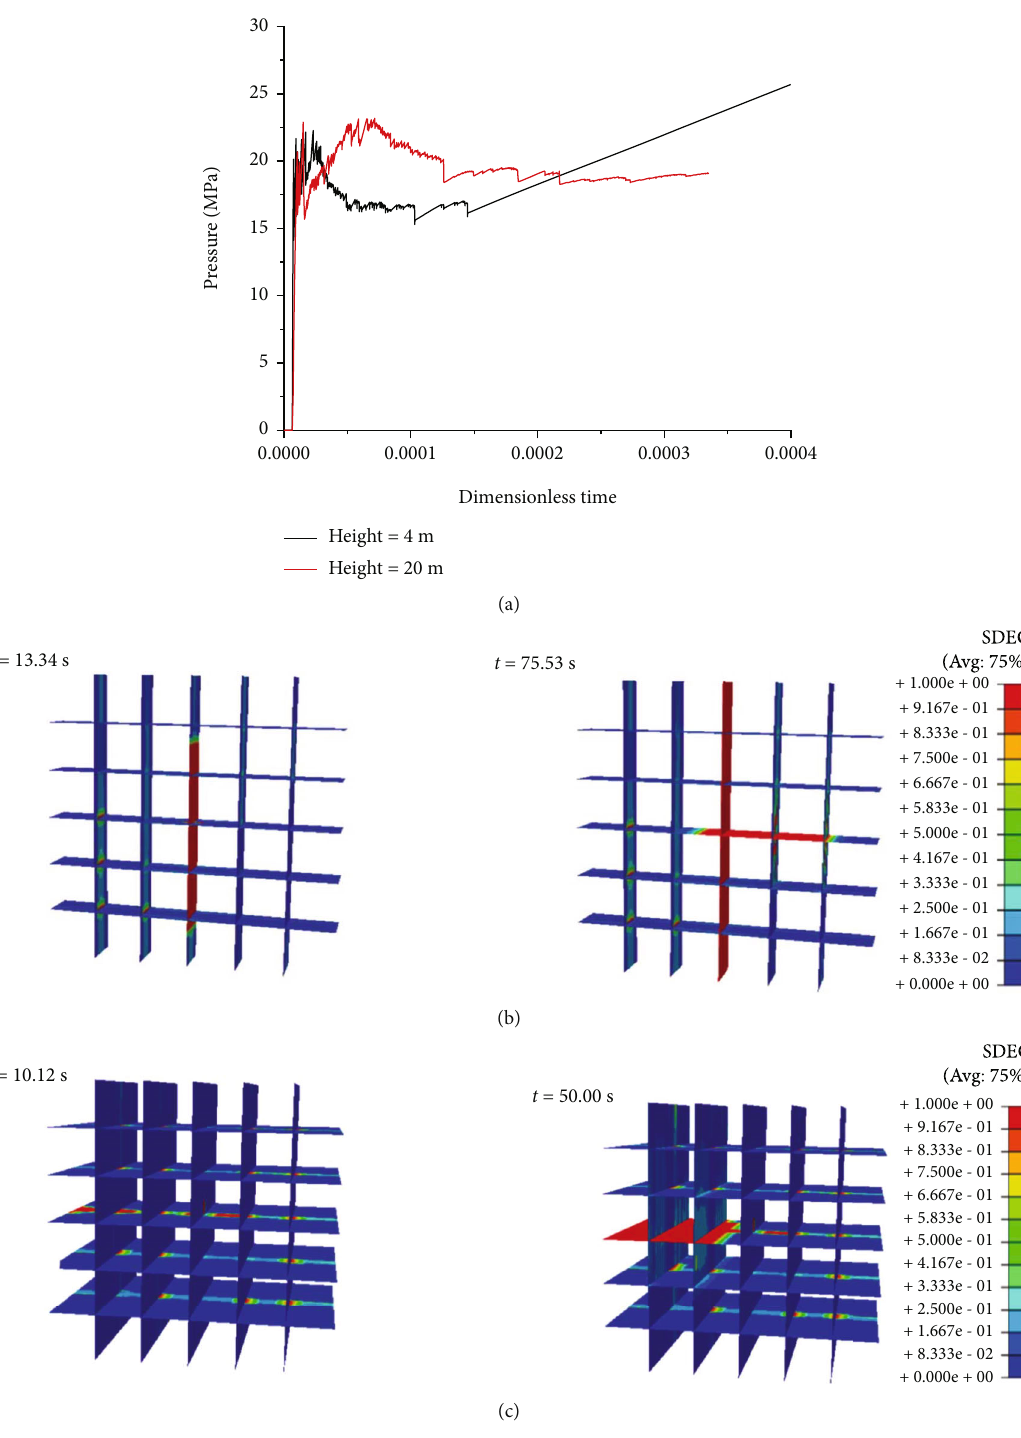
Figure 16: The numerical results at a 90-degree approaching angle with 4 m/20m formation thickness: (a) the fl uid pressure history at the injection point; (b) damage factor with 4m formation thickness (deformation scale factor is 100); and (c) damage factor contours with 20 m formation